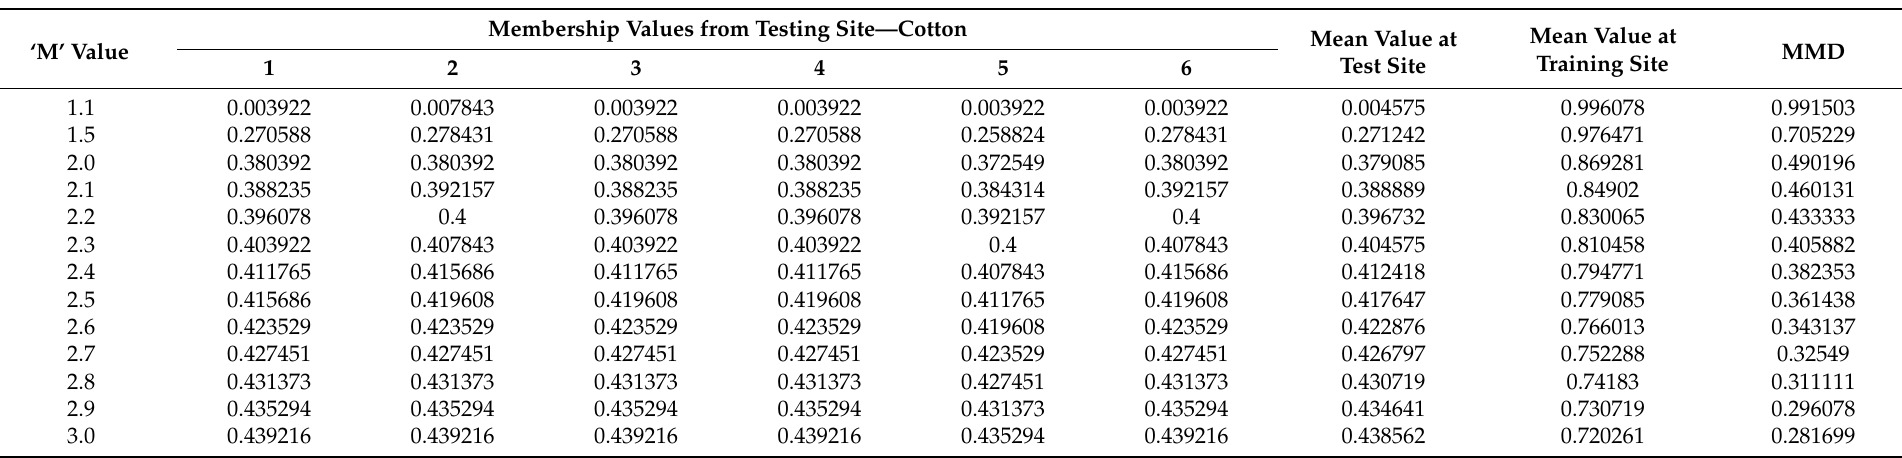
Table 8. Varying ‘m’ values with MMD exhibiting Departure of Pigeon Pea Training Fields from the Cotton Test Fields—ISM training parameter based PCM